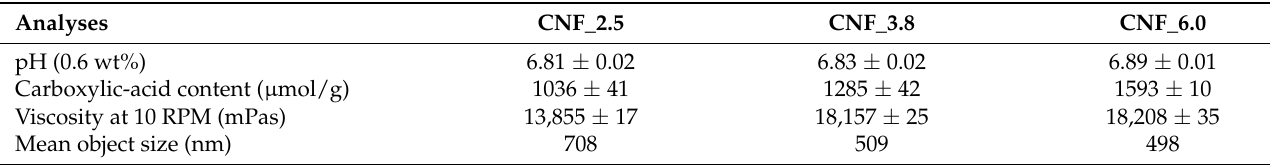
Table 1. CNF characterization. Values reproduced from